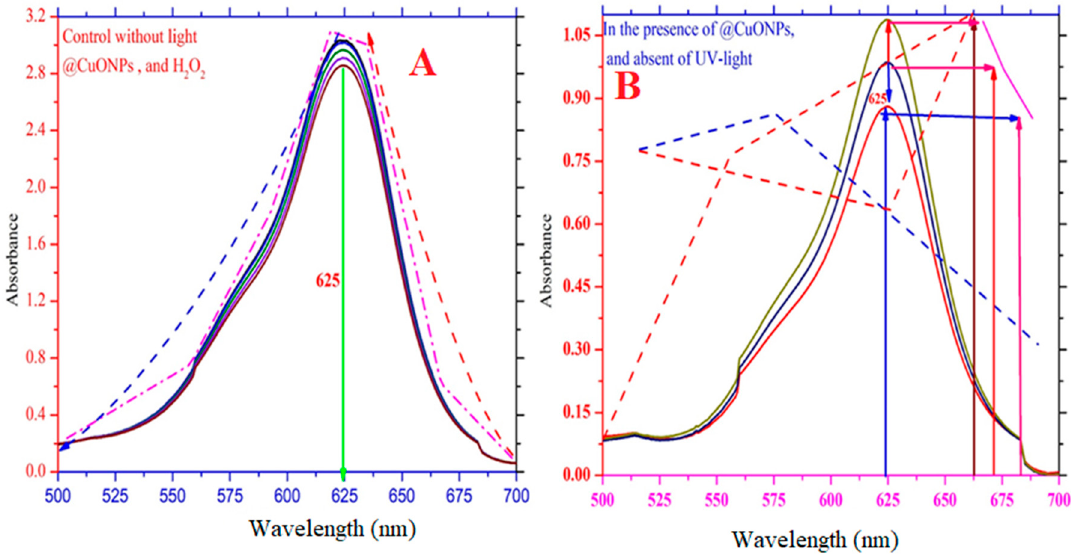
Figure 8. Photo-degradation of Congo red dye: ( A ) Effect of light control; ( B ) Effect of catalyst.